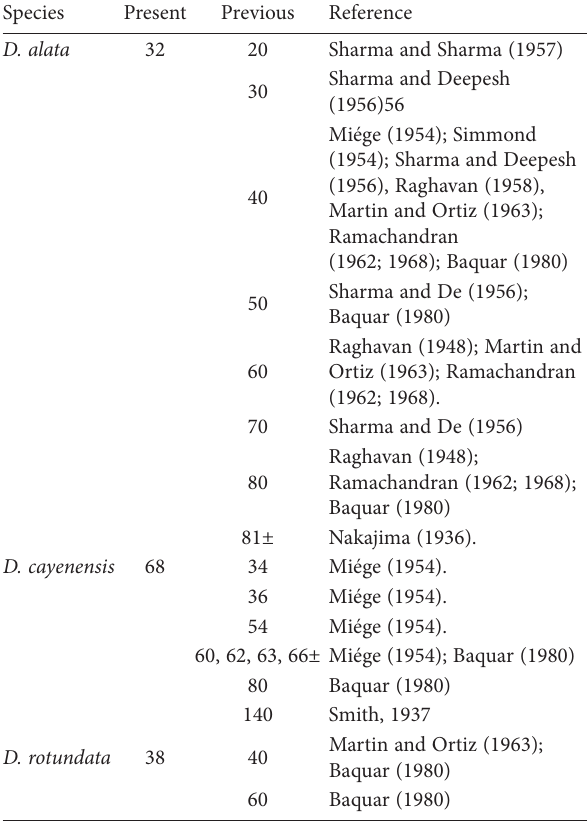
Table 2. Present and previous reports of chromosome numbers in the genus Dioscorea